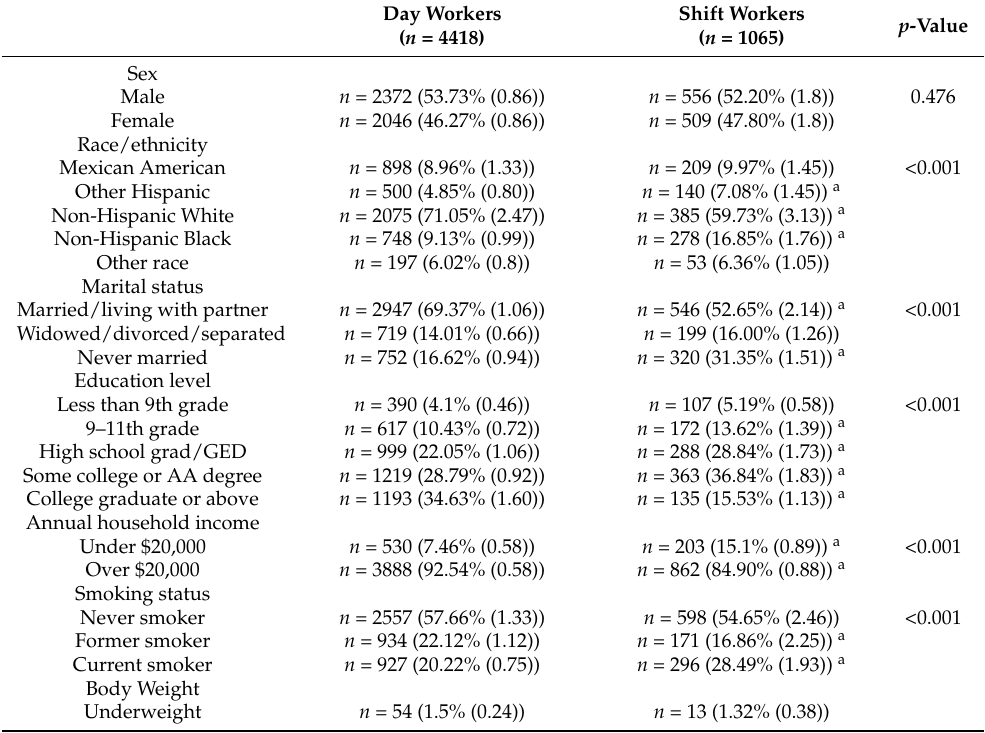
Table 1. Study sample characteristics: a comparison by shiftwork status.